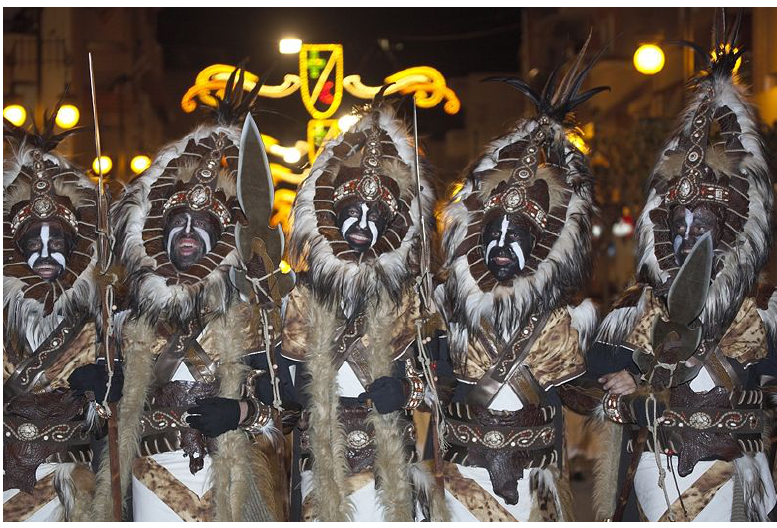
Photo by Bereber. Courtesy of Wikimedia Commons [27]. Figure 2. The Moors “disembark”. Town of Villajoyosa, Alicante province.